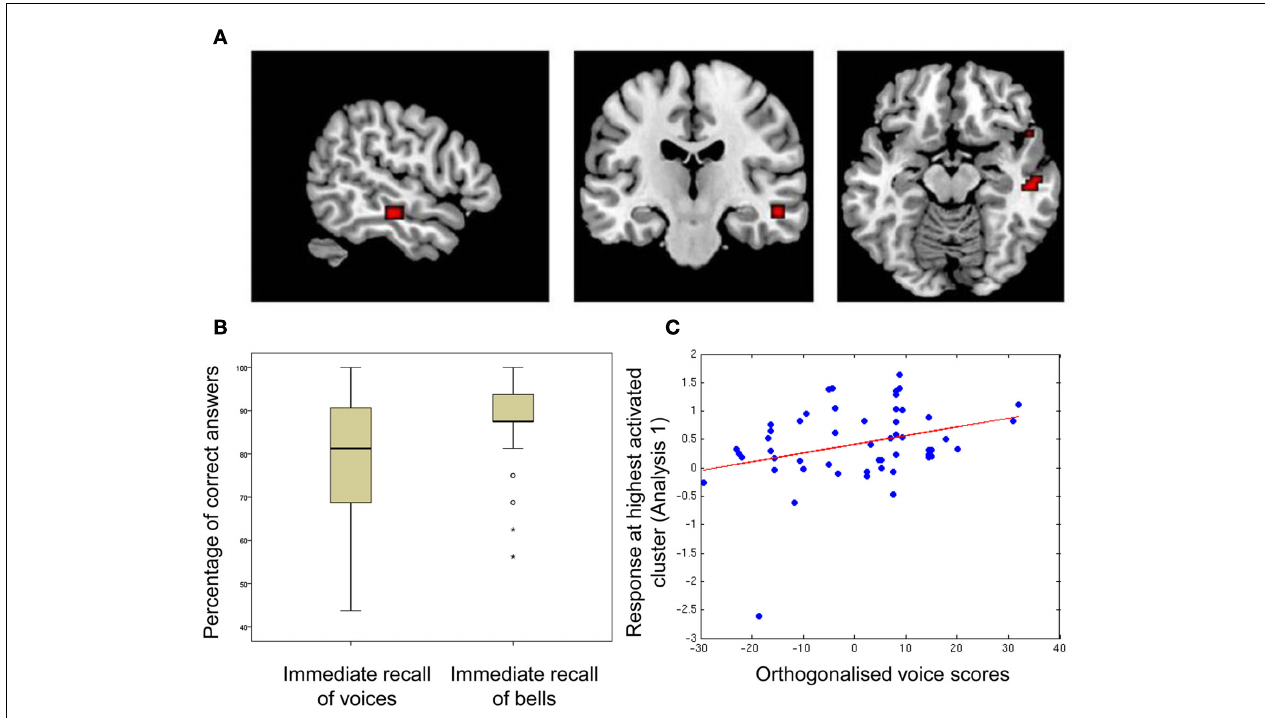
FIGURE 1 | Correlation between memory scores and sound-responsive activity in temporal voice areas, (A) regions of significant correlation between fMRI signal and voice memory score; (B) boxplots of scores for voice- and bell-memory tasks; (C) fitted response at the highest activated cluster obtained inAnalysis 1 (absolute maximum (MNI space): 54 − 19 − 14) in relation to voice scores orthogonalized relative to memory for bell sounds.